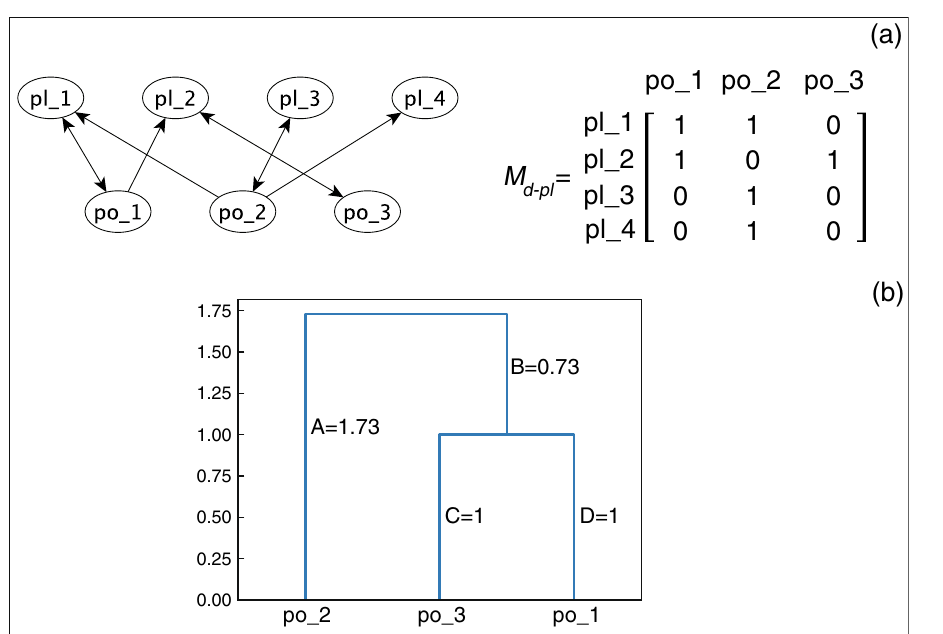
Figure 13. Calculation of functional diversity for a subset of the community. ( a ) Illustrates an interaction network with 4 plant and 3 pollinator nodes and the directed adjacency matrix M d − pl containing the binary information on the edges incoming to plant nodes. ( b ) Shows the dendrogram resulted when the matrix M d − pl was used for clustering. There are four branches labeled with letters A through D. The functional diversity of any subset of the dendrogram is equal to the sum of the branch lengths (considering the branches from the base of the dendrogram) of that subset. For example, the branch length corresponding to po_3 is the sum of the lengths of branches B and C, i.e.